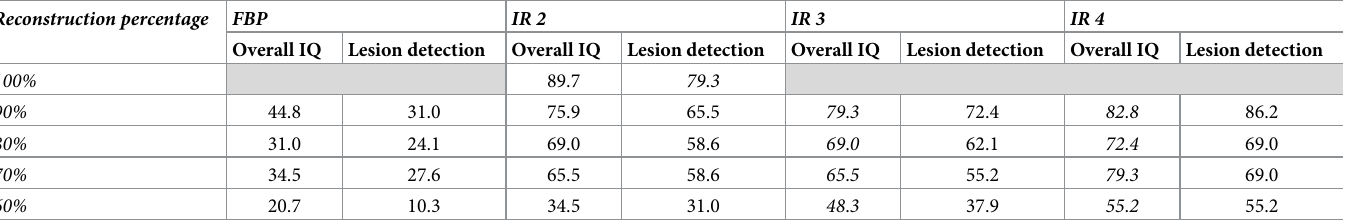
Table 3. Percentage of scans rated as of good or excellent diagnostic image quality, and rated as good or excellent lesion detection capability, set out per reconstruc- tion method. Reconstruction percentage